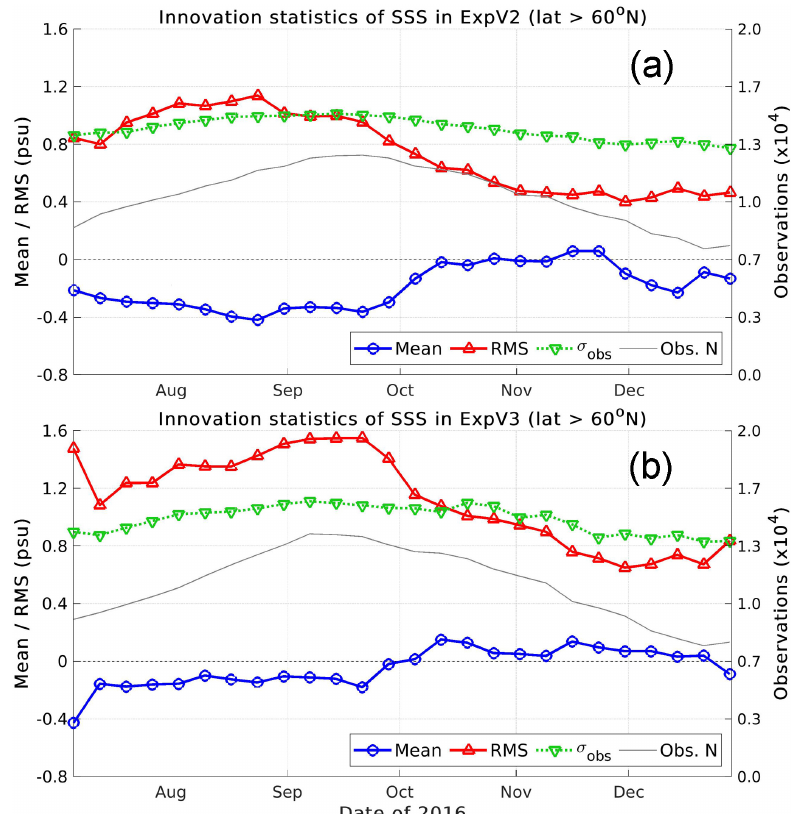
Figure 3. Innovation statistics of SSS in the Arctic ( > 60 ◦ N) from ExpV2 (a) and ExpV3 (b) . The line with red triangles is the root- mean-squared innovation, and the dotted blue line shows the mean of innovations north of 60 ◦ N. The gray line represents the number of observations assimilated, and the green line with inverted triangles is the observation error standard deviation in the two